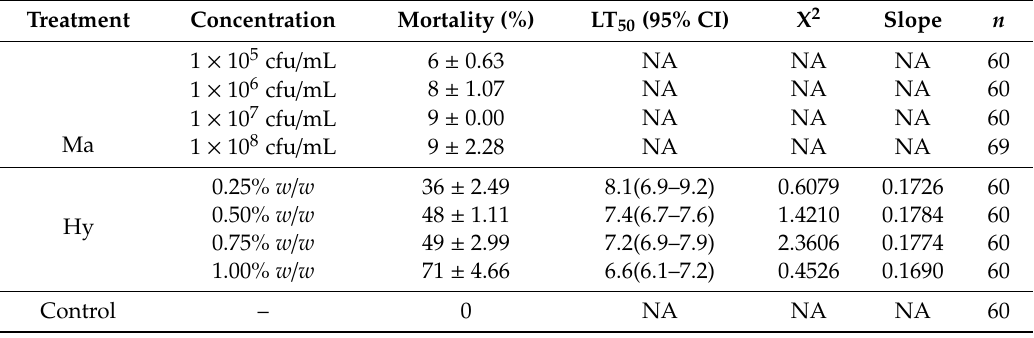
Table 1. Mortality of B. germanica adult males fed various concentrations of M. anisopliae and various concentrations of